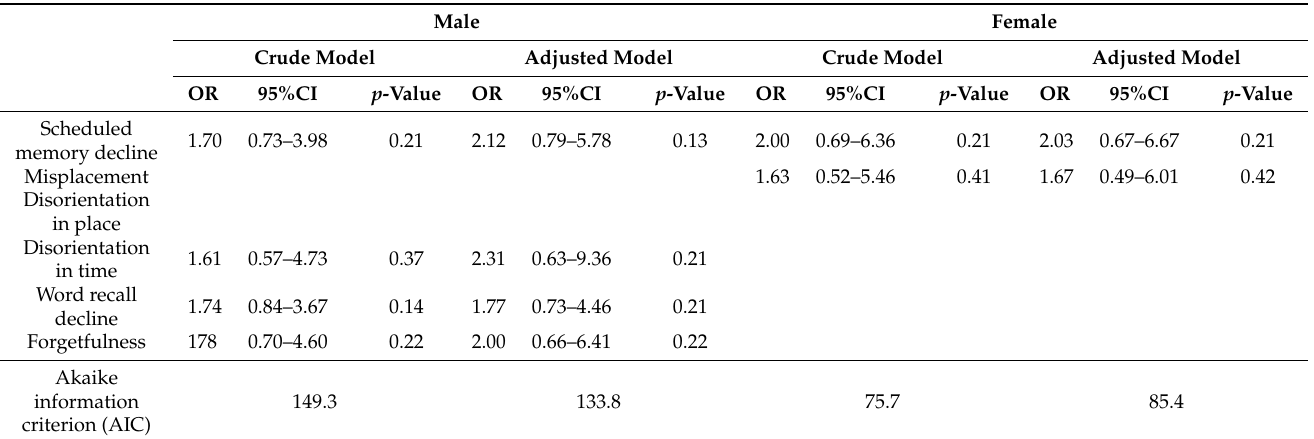
Table 4. Association between the sleep onset problem and subjective cognitive complaints in male group and female group. Male